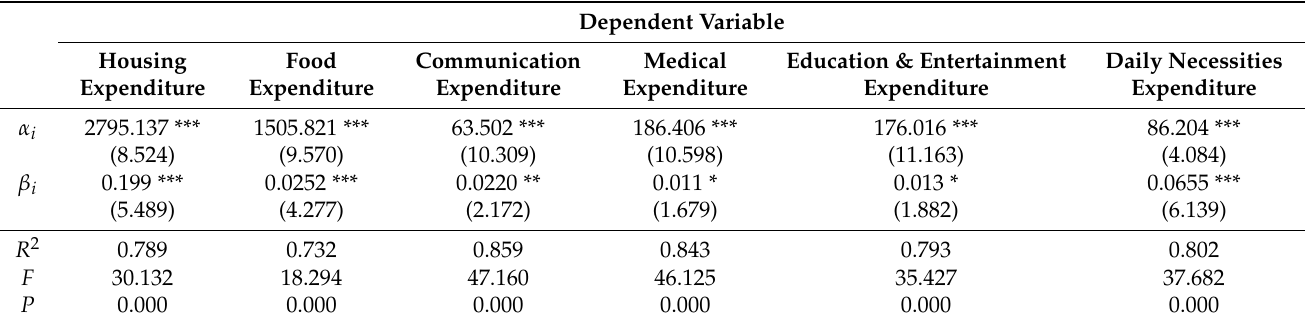
Table A3. Linear regression results of rural resettled in